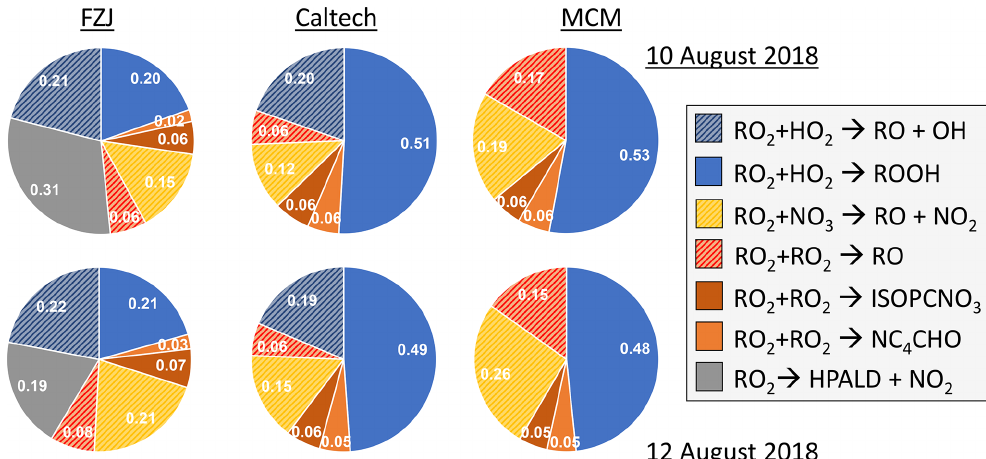
Figure A3. Relative distribution of loss rates of nitrate RO 2 for the experiment on 10 August 2018 (Experiment 2) and on 12 August 2018 (Experiment 3). The total RO 2 loss rate was 0.005 and 0.008s − 1 in the experiment on 10 August 2018 (Experiment 2) and 12 August 2018 (Experiment 3), respectively. Calculations of the loss rates of RO 2 radicals in bimolecular reactions make use of measured HO 2 and NO 3 concentrations. Total RO 2 concentrations and concentrations of speciated nitrate RO 2 were taken from model calculations applying the FZJ- NO3 mechanism, Caltech mechanism or MCM. The chemical mechanisms differ with respect to the number of nitrate RO 2 isomers that are considered, the type of RO 2 loss reactions and products of loss reactions (Figs. 3 and 6). Therefore, the distributions of nitrate RO 2 radicals and RO 2 concentrations differ between the model runs.